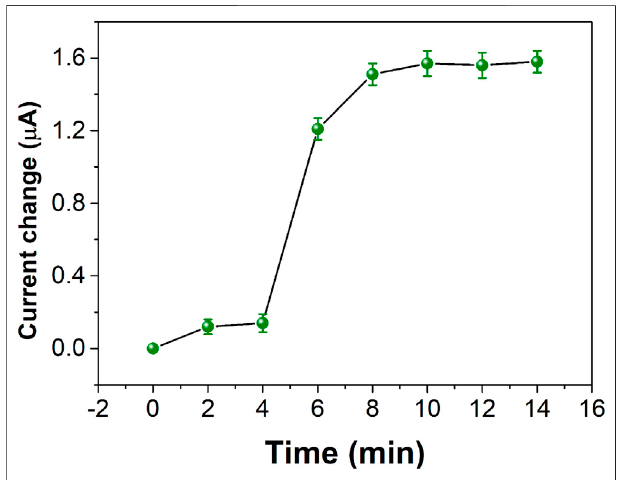
FIGURE4| Currentovertimefor E.coli ATCC25922interactingwithMB for different